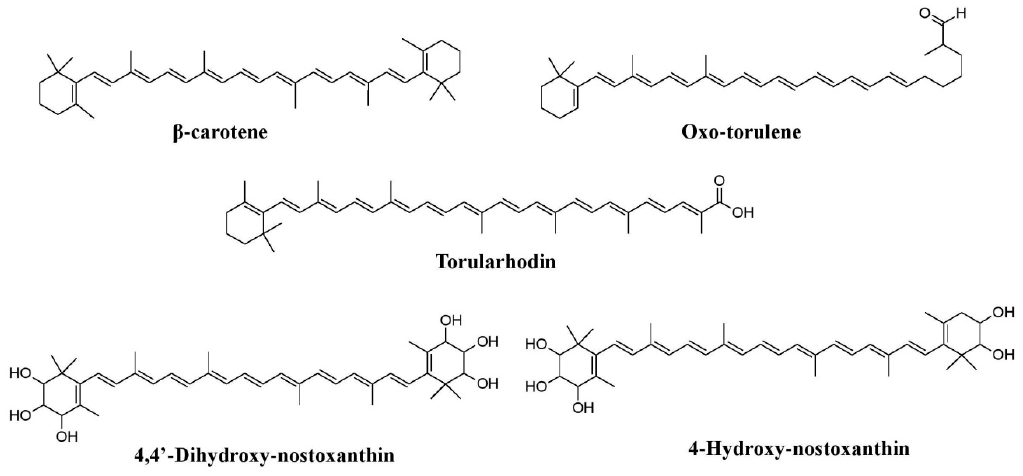
Figure 10. Pigments reported from yeasts such as Rhodotorula glutini and Xanthophyllomyces dendrorhous , re-drawn from [13,128].